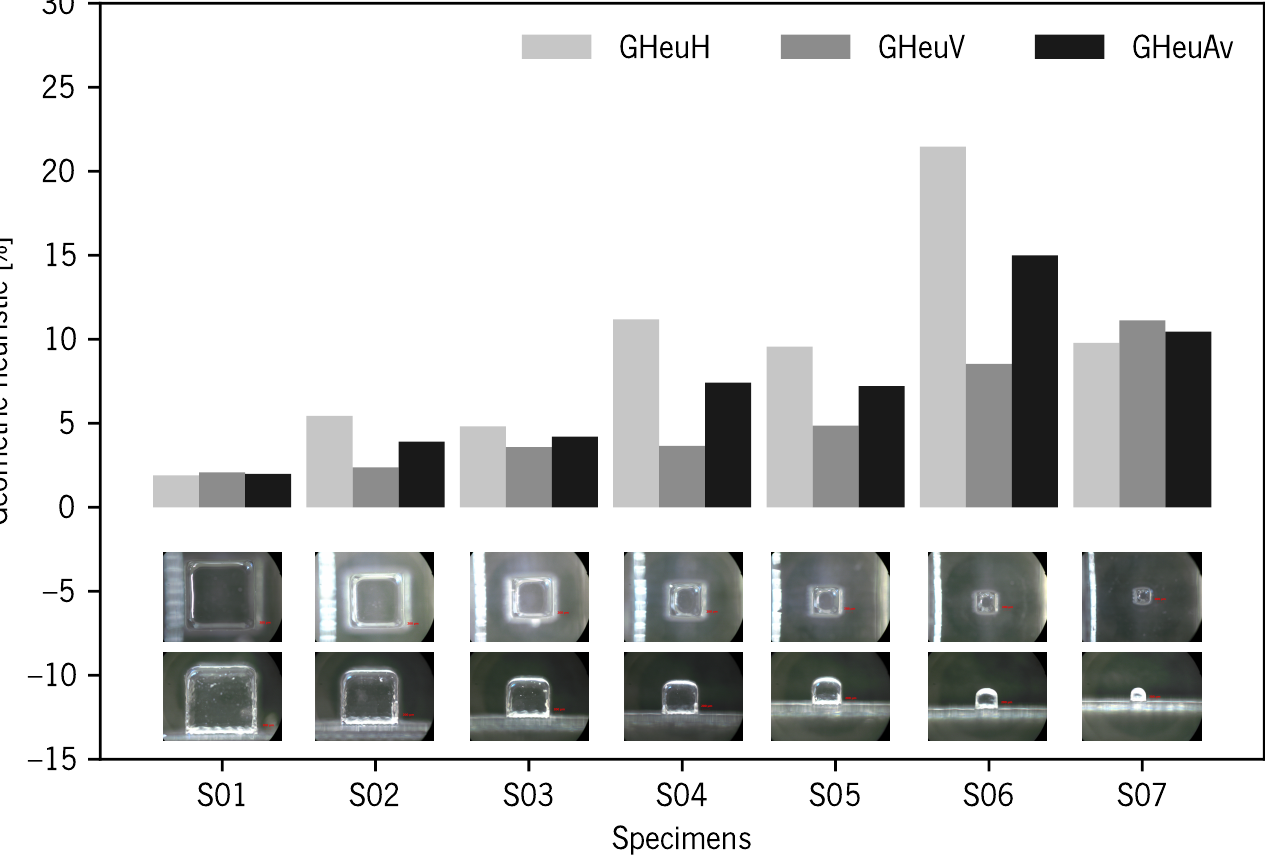
Figure 7. Geometric heuristic diagram for specimens produced without support material. Below the diagram, the representative images corresponding to each